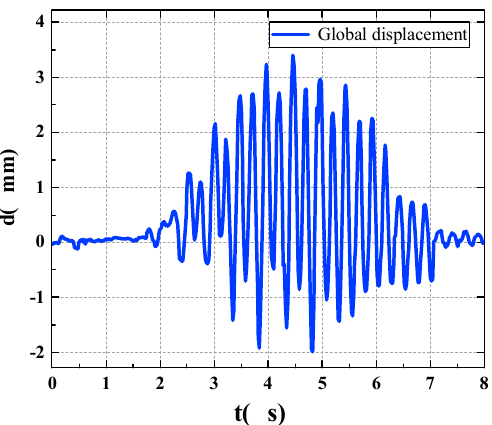
Figure 11. Multipoint displacement recognition results.